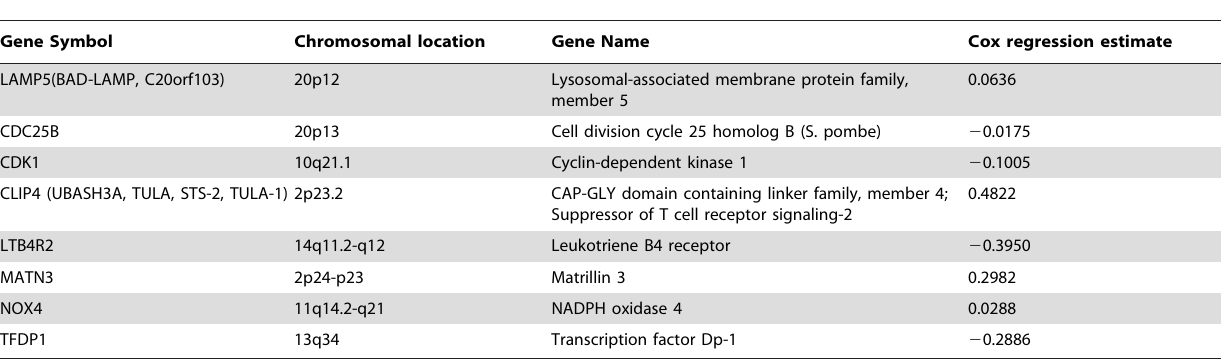
Table 1. List of genes that constitute Gastric Cancer Prognostic Score and their Cox regression estimates used to calculate the